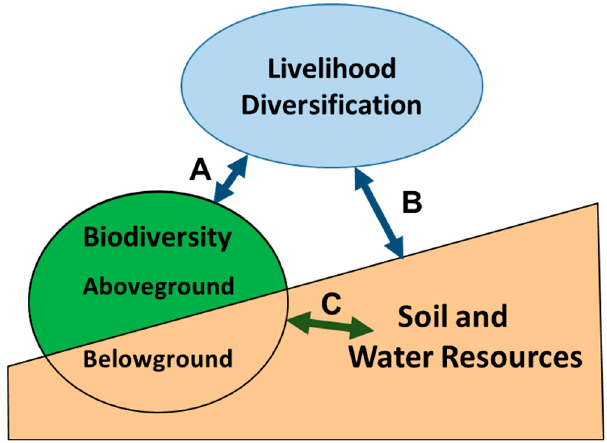
Figure 1. Conceptual diagram of the linkages of livelihood diversification to agrobiodiversity, as both aboveground and belowground sub-components, and to soil and water resources. Arrows A and B represent principal linkages of livelihoods to natural systems; C represents coupling between natural resources and agrobiodiversity.